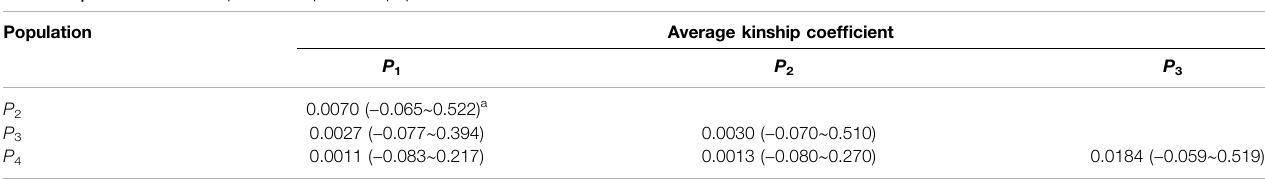
TABLE 2 | Genetic relationship between pair-wise